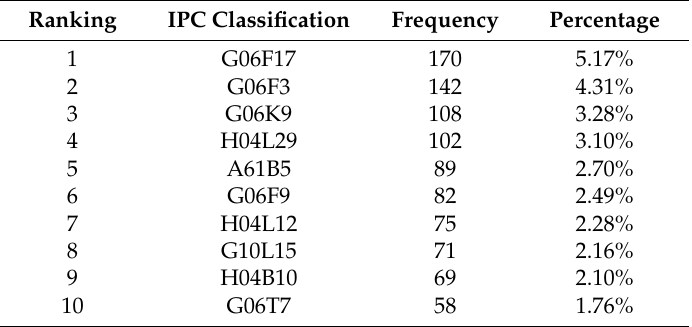
Table 1. Top 10 International Patent Classifications (IPCs) to the fourth digit.